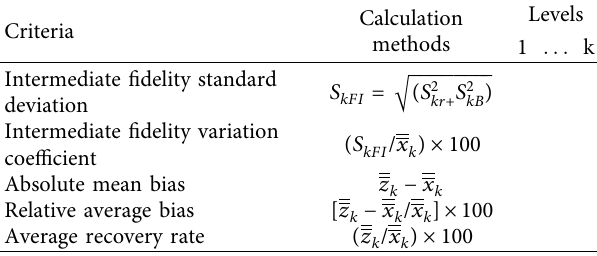
Table 4: Mode of calculation of the criteria of fidelity and trueness by level.